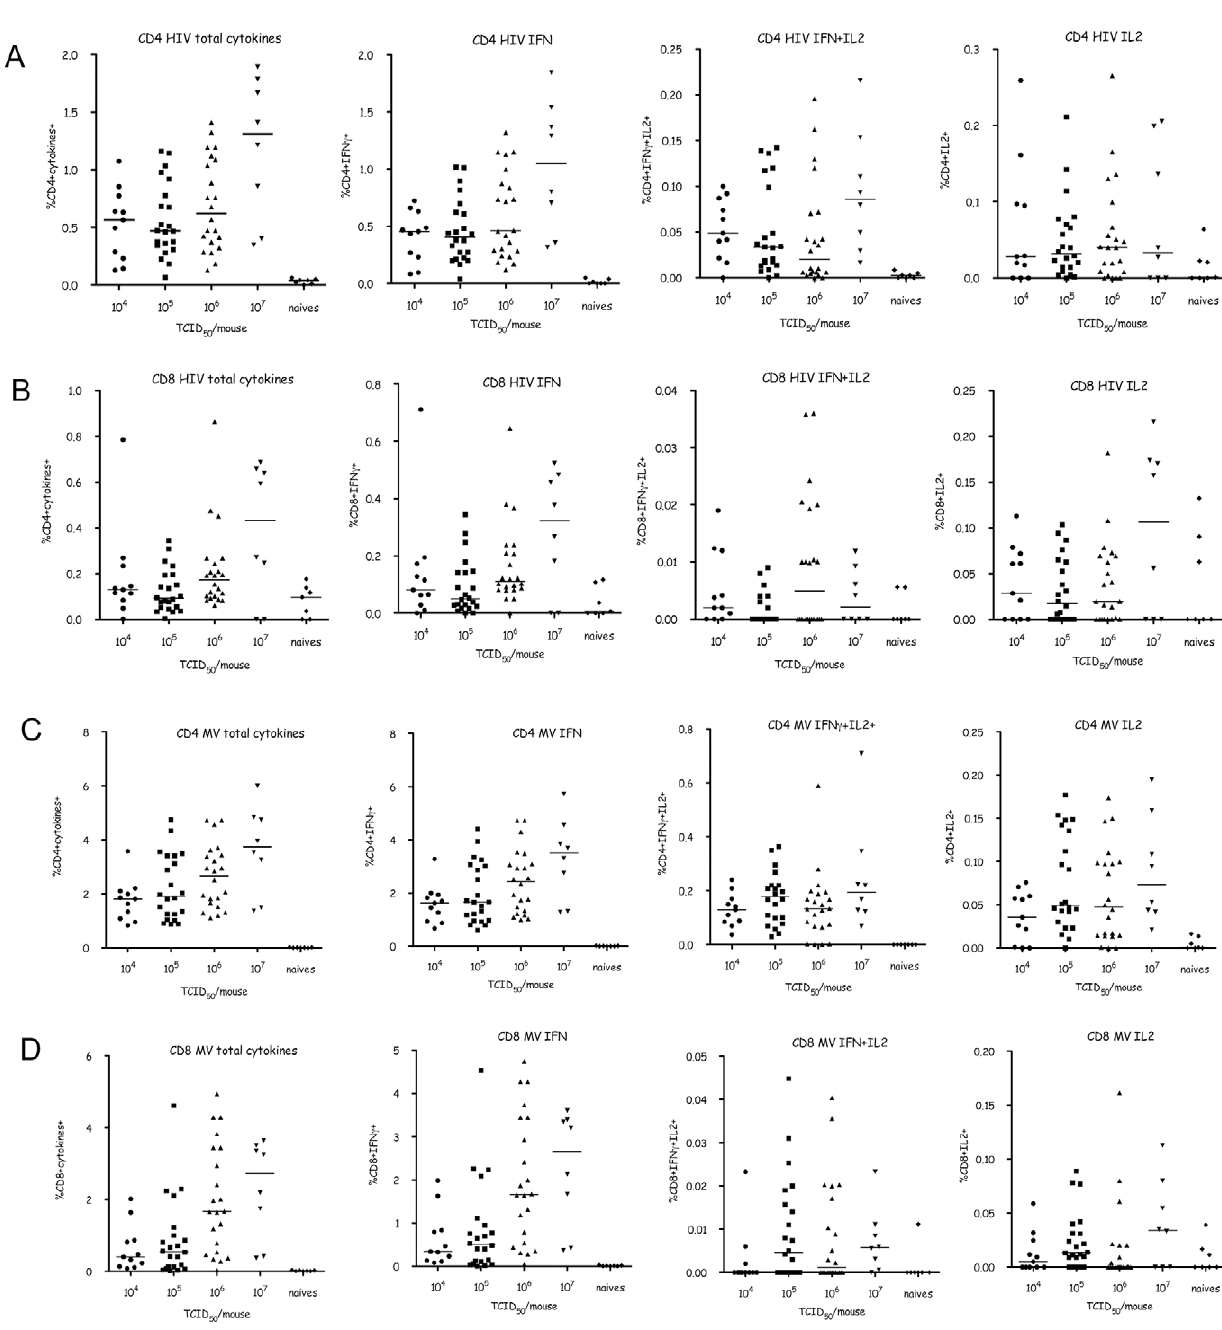
Figure 1. Murine T cell cytokine responses to HIV-1 F4 peptides and MV. Responses of splenocytes from CD46/IFNAR mice immunised with 10 4 –10 7 TCID 50 MV1-F4 analysed by flow cytometry for their capacity to secrete IFN c and IL-2 upon specific stimulation compared to naive controls. IFN + IL-2 indicate a response by double positive cells. Panels A and B show responses to HIV-1 F4 peptide pools by CD4 + and CD8 + T cells, respectively. Panels C and D show responses to MV by CD4 + and CD8 + T cells, respectively. (Figure 5C). Significant CD4 + T cell cytokine responses against MV were detected in all group A and B macaques, except F55 (Figure 6A and B). Overall CD4 + T cell responses against MV were greater in group A than B, declined sharply at day 84 in both groups but significant responses were still detected in the lymphoid tissues of F51, F52, F53 and F58 at termination (Figure 6A and B). Significant CD8 + T cell cytokine responses against MV were only